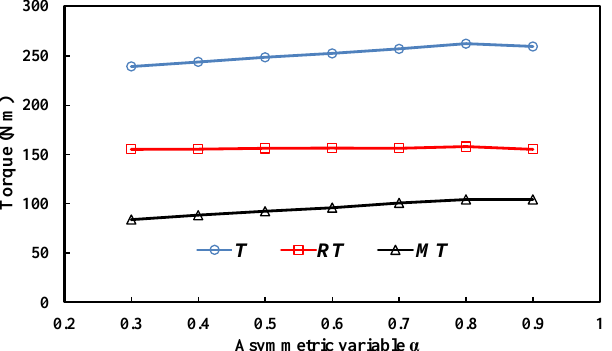
Figure 6. The total torque and torque components versus the asymmetry coefficient α . After the optimization, the optimal asymmetrical structure is confirmed. The opti- mized design parameters of the proposed MAS-IPM machine are obtained, i.e., h 1 = 3.9 mm, h 2 = 2.7 mm, l pm 1 = 18.4 mm, l pm 2 = 23 mm, l pm 3 = 33 mm, and α = 0.8. 4. Performance Comparison 4.1. No-Load Performance The back-EMFs at rated speed of the two investigated machines are shown in Figure 7. It can be found that the root-mean-square (RMS) EMF of the proposed machine is 20.2% higher than that of the Prius machine. Meanwhile, it shows that the MAS-IPM machine exhibits better sinusoidal back-EMF than the conventional machine. The cogging torque waveforms are illustrated in Figure 8. It can be seen that the Prius 2010 machine exhibits higher cogging torque than the MAS-IPM machine. This is mainly attributed to lower THD of the back-EMF of the proposed MAS-IPM machine. ( a ) ( b ) Figure 7. No-load back-EMFs of the two investigated machines (3000 rpm). ( a ) Waveforms. ( b ) Harmonic spectra. Figure 8. Cogging torque waveforms. 4.2. Torque Characteristics